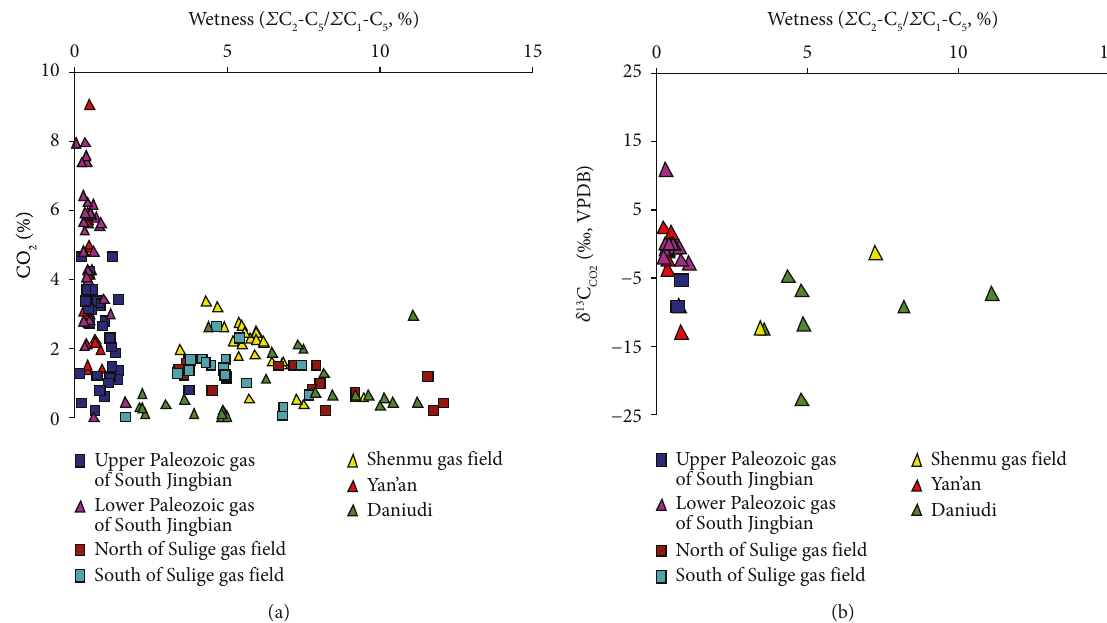
Figure 12: (a) CO content versus wetness (modi fi ed from [15]); (b) δ 13 C-CO 2